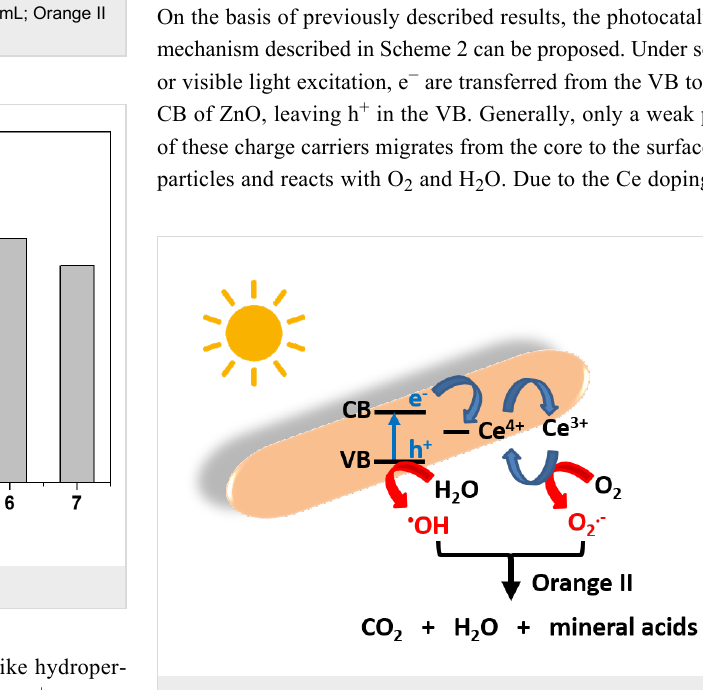
Scheme 2: Schematic representation of the photocatalytic activity of ZnO:Ce rods.